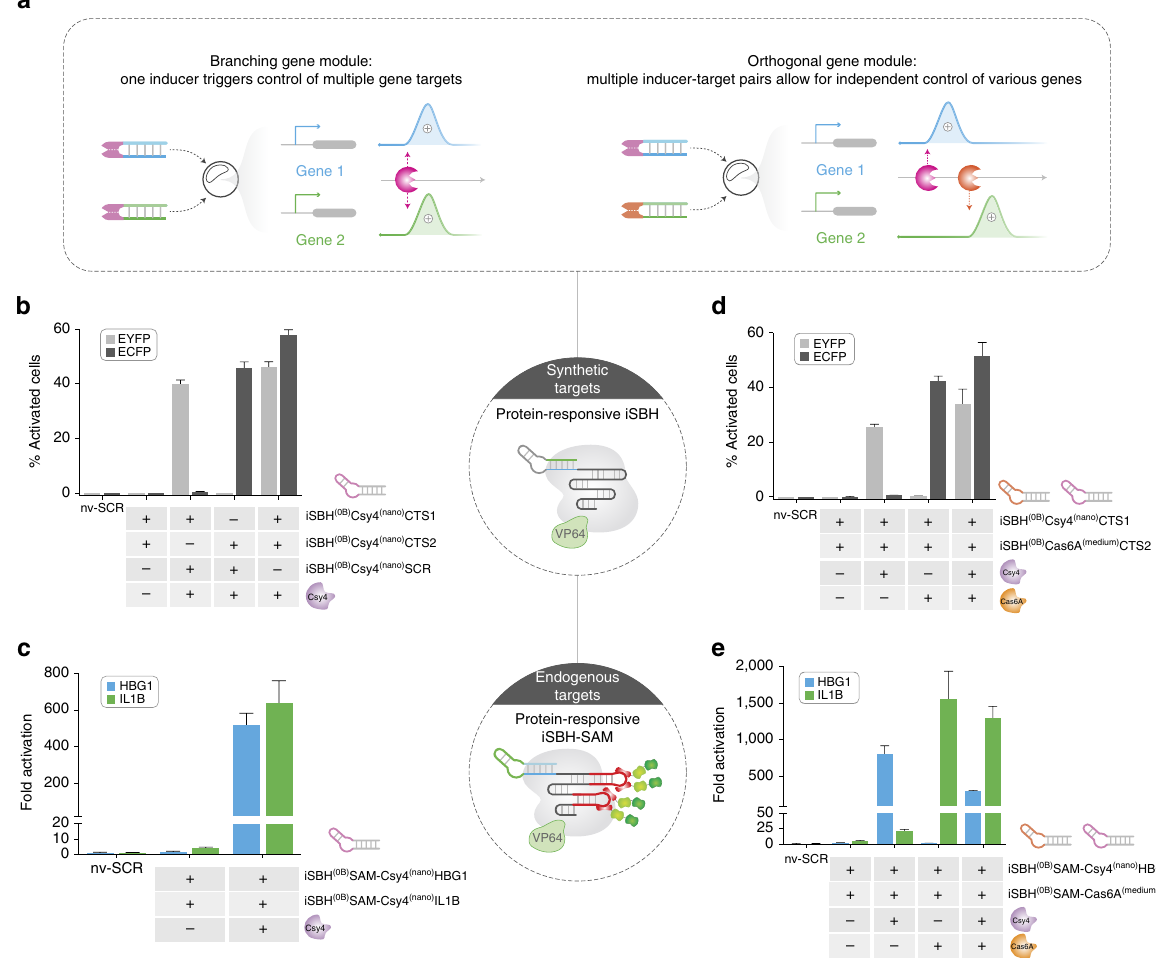
Figure 4 | Assembly of gene network modules with protein-responsive iSBH sgRNAs. ( a ) Schematic representation of branching and orthogonal gene network modules using iSBH-sgRNAs. iSBH-sgRNAs programmed with specific sensing loops (purple and orange) and/or spacers (blue and green) enable rapid generation of parallel and orthogonal inducer/target gene pairs, facilitating synchronous or asynchronous control of transcriptional programs. ( b ) Concurrent activation of two reporter genes using protein-responsive iSBH-sgRNAs (branching module). Csy4-responsive iSBH (0B) Csy4 (nano) CTS1 and iSBH (0B) Csy4 (nano) CTS2 were co-transfected in the absence or presence of the inducer. To confirm Csy4-mediated specific activation of CTS1 and CTS2 target genes, each corresponding iSBH-sgRNA was co-transfected with a control iSBH-sgRNA carrying a scramble spacer (iSBH (0B) Csy4 (nano) SCR). ( c ) Concurrent overexpression of two endogenous genes ( HBG1 and IL1B ) using Csy4-responsive iSBH-sgRNAs (branching module). Co-transfection